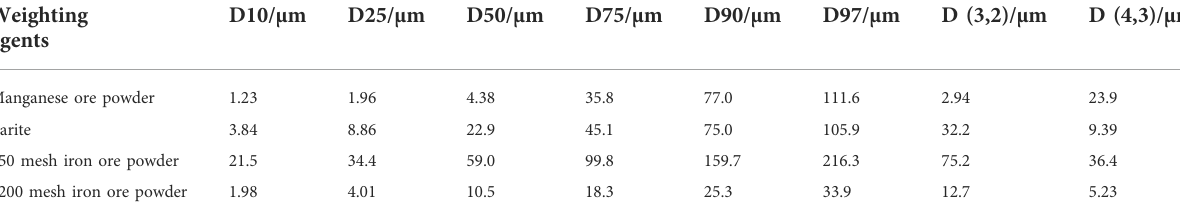
TABLE 2 Particle size distribution of different types of weighting